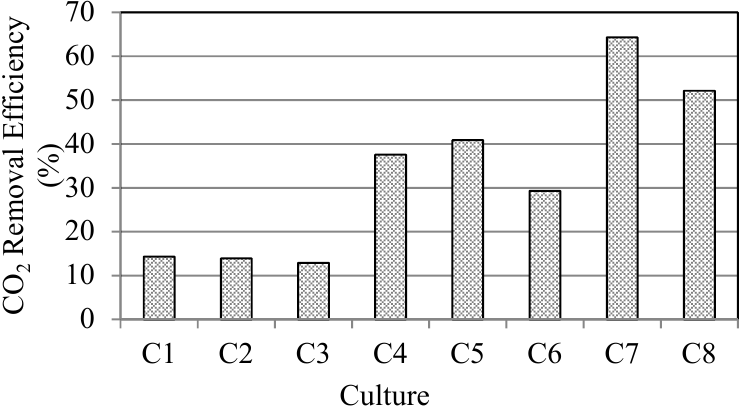
ffi ciency of all